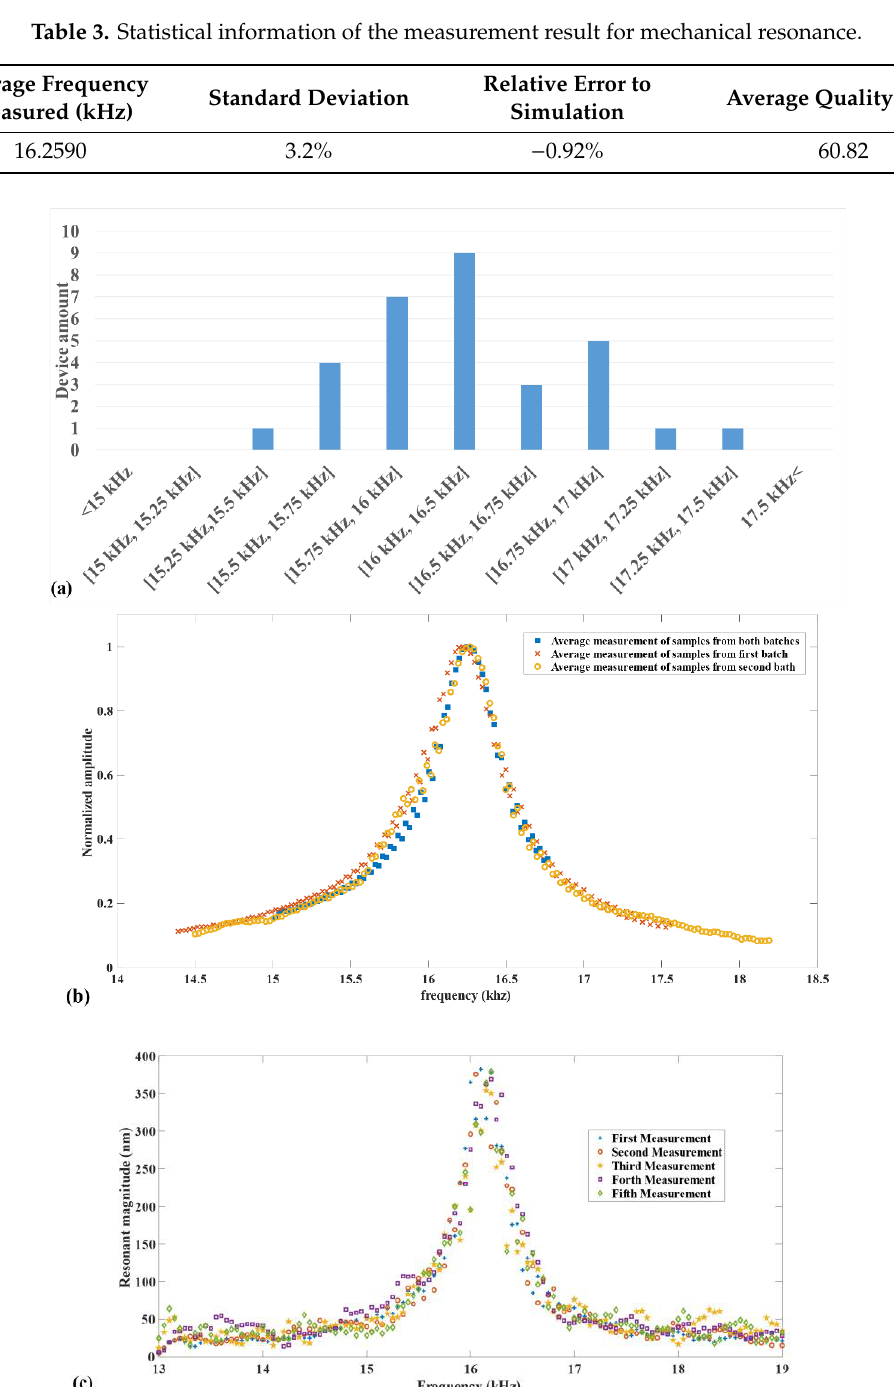
Figure 8. Visualization of the mechanical resonant measurement for the 30 selected proof-of-concept structures. ( a ) Distribution of resonant frequency of individual test structures. ( b ) Comparison of the average resonance profile between the two batches. ( c ) 5 separate measurement results for a single structure.